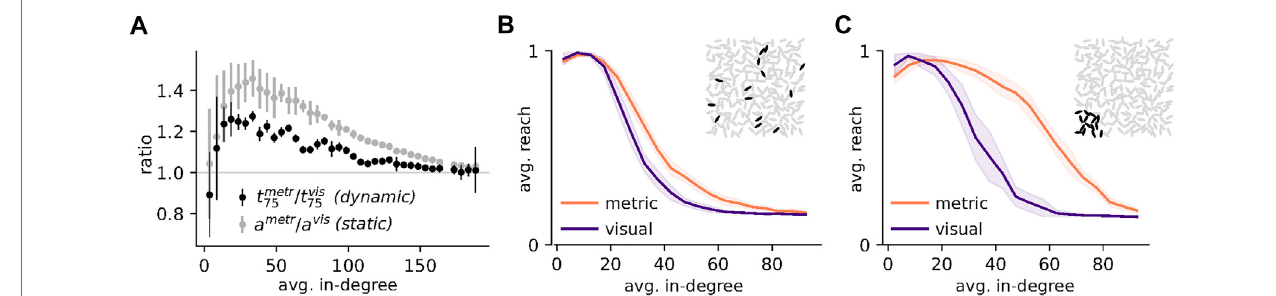
FIGURE 5 | Structural differences in fl uence dynamics on networks: (A) The ratio of contagion speeds (time to75% infected or recovered, t metr 75 / t vis 75 ) shows a similar dependenceonaveragein-degreeastheratioofaverageshortestpathlengths( a metr / a vis ,grey).Dotsrepresentaveragesanderrorbarsonestandarddeviationover100 networks (static) or 100 runs on 100 networks (dynamic). (B) and (C) Effect of clustering coef fi cient on fractional contagion. (B) Initial activation by 15 randomly selected individuals (see black ellipses in inset for an example). (C) Initial activation by 15 individuals in one corner of the group (inset). Lines represent averages over 100 networks with 100 runs of the fractional contagion dynamic each, shaded areas represent one standard deviation of the networks, average reach. A higher clustering coef fi cient (as in metric networks, compare Figure 3) is bene fi cial for a spatially clustered initial activation, (C). Parameters: N (cid:1) 225, Φ ∈ [0.0, 0.3], γ (cid:1) 0.01, β (cid:1) 0.3, r 0 (cid:1) 0.4, σ (cid:1)